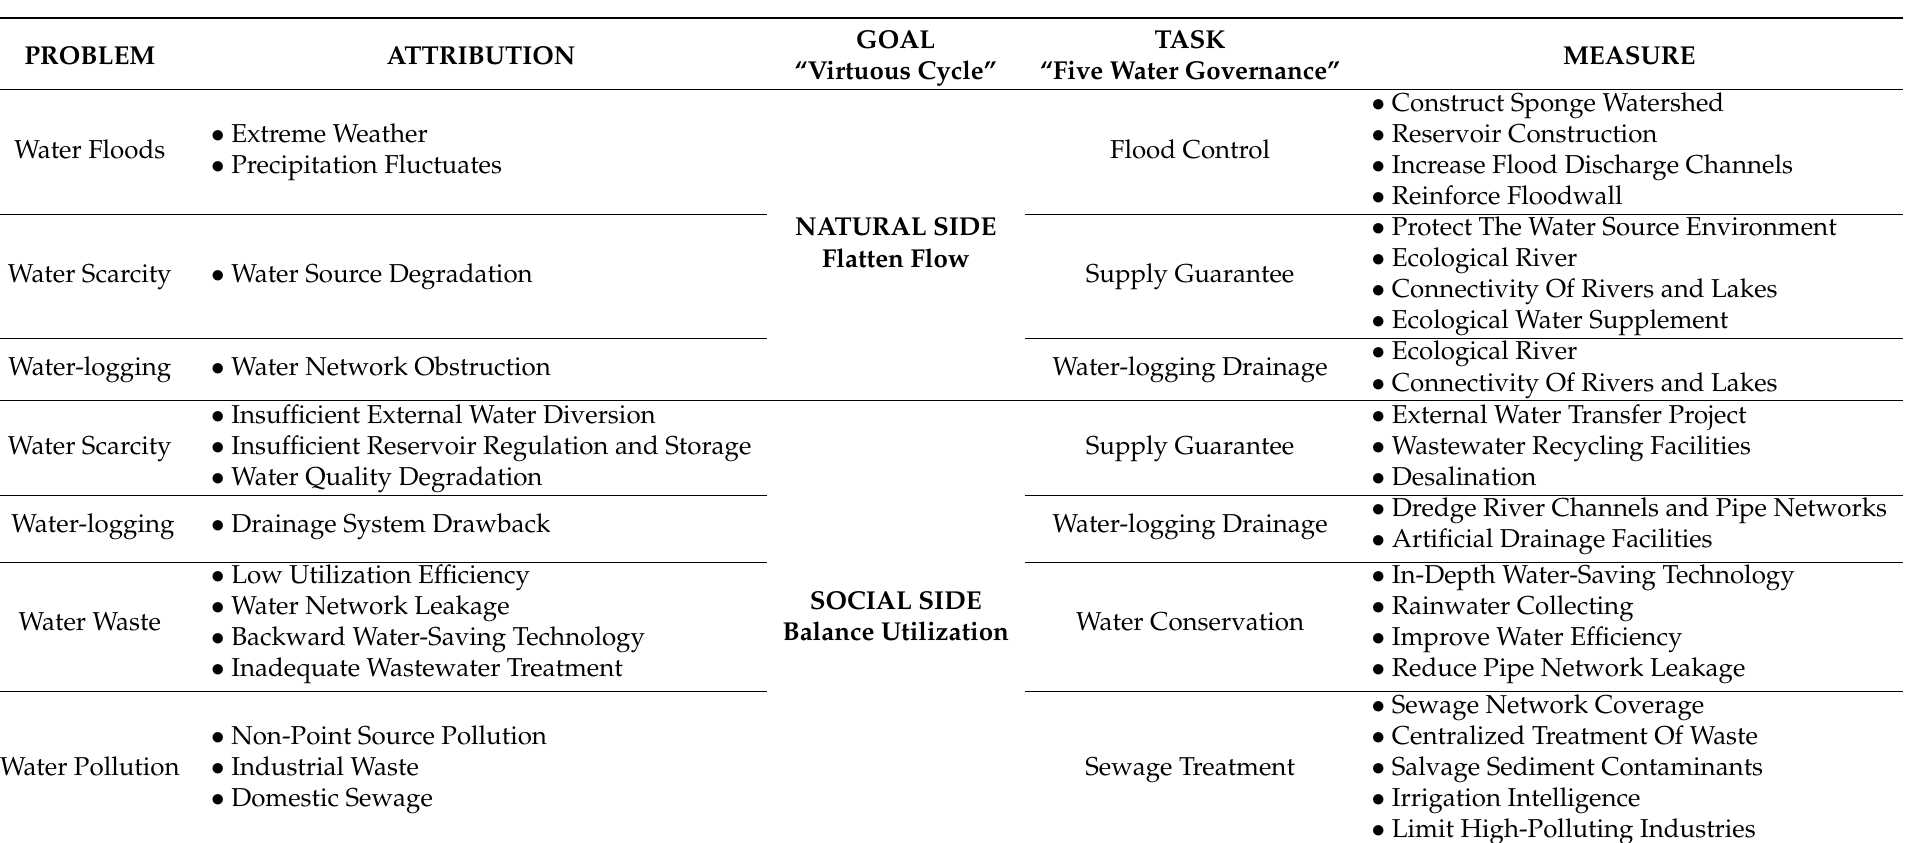
Table 1. PAGTM of the Virtuous Cycle in Zhejiang Province,